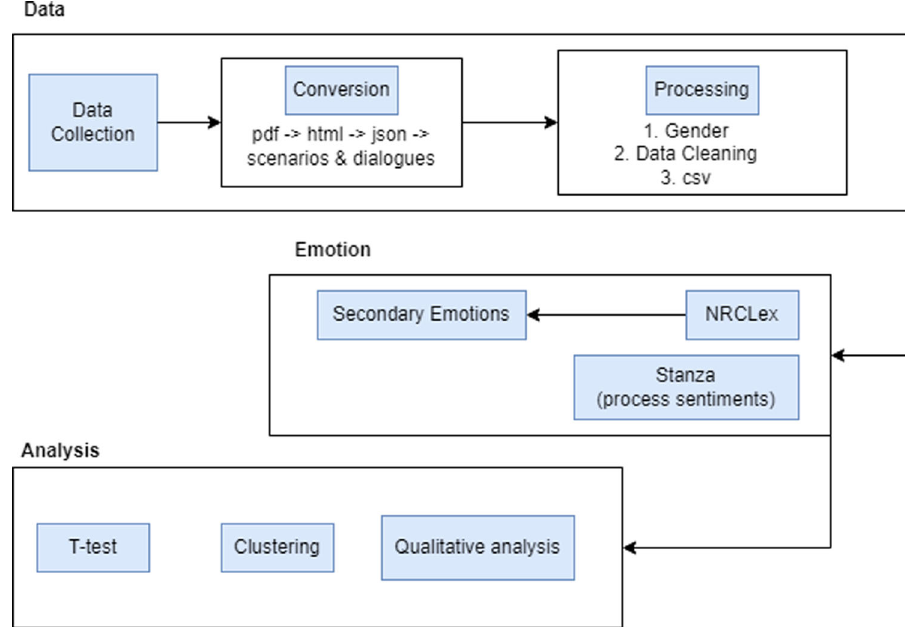
Fig. 1 Work fl ow of the study including three modules. (1) data processing module, (2) emotion detection module, and (3) analysis